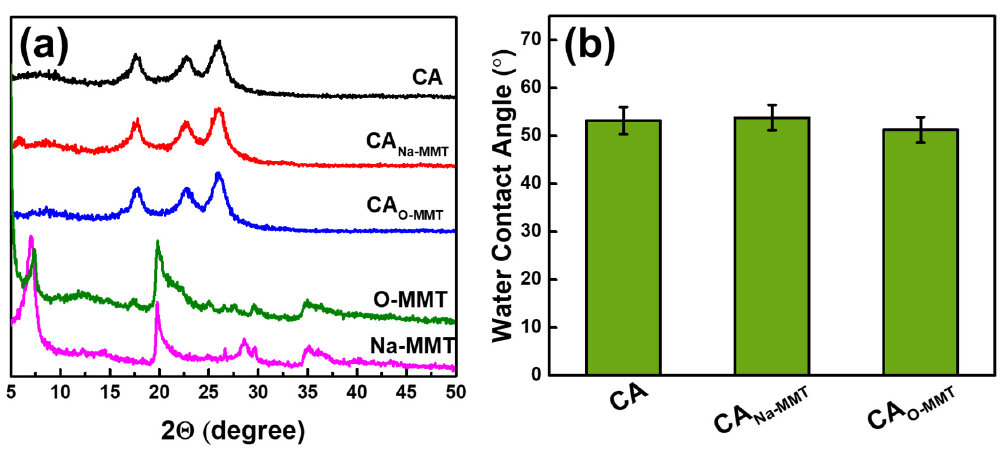
Figure 4. ( a ) XRD pattern of particles and membranes and ( b ) water contact angle of membranes.